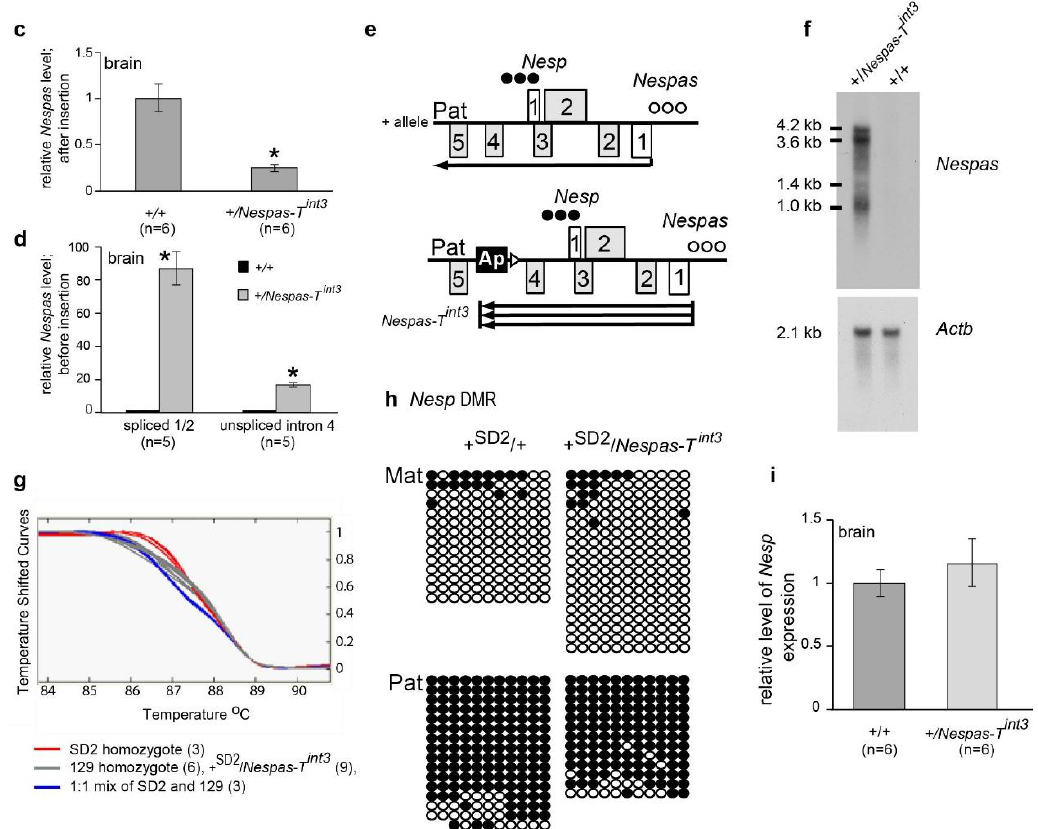
Figure 4. Truncation of Nespas after the Nesp promoter in Nespas intron 4. ( a ) Schematic of the mouse Gnas locus showing the site of insertion of the rabbit β-globin polyadenylation cassette (black box labelled Ap) to truncate Nespas and the position of the selection cassette flanked by loxP sites (open triangles). The selection cassette was deleted on germline transmission and the targeted allele was designated Nespas-T int3 . A, Afl II; B, Bsr GI; X, Xho I; ( b ) Southern analysis of ES cell DNA showing correct targeting. Correctly targeted clones were identified by the presence of a 14.1 kb Afl II fragment detected with the 5′ external probe, probe A. Correct targeting at the 3′ end was confirmed by the detection of a 16.3 kb Bsr GI fragment with probe B; ( c ) Nespas is downregulated after the insertion; ( d ) Nespas is upregulated before the insertion. There was a greater fold difference in the spliced form (exon 1 spliced onto exon 2) than the unspliced form (intron 4); ( e ) Nespas is truncated and abundant in +/ Nespas-T int3 ; ( f ) Northern blot assay of Nespas and loading control Actb ; ( g ) Light Scanner melt profile, using a SNP in Nespas exon 3, to show Nespas is expressed from the paternal allele in +/ Nespas-T int3 ; ( h ) Bisulphite analysis showing the Nesp DMR is unmethylated on the maternal allele and methylated on the paternal allele in + SD2 / NespasT int3 ; ( i ) The Nesp level is unaffected in +/ Nespas-T int3